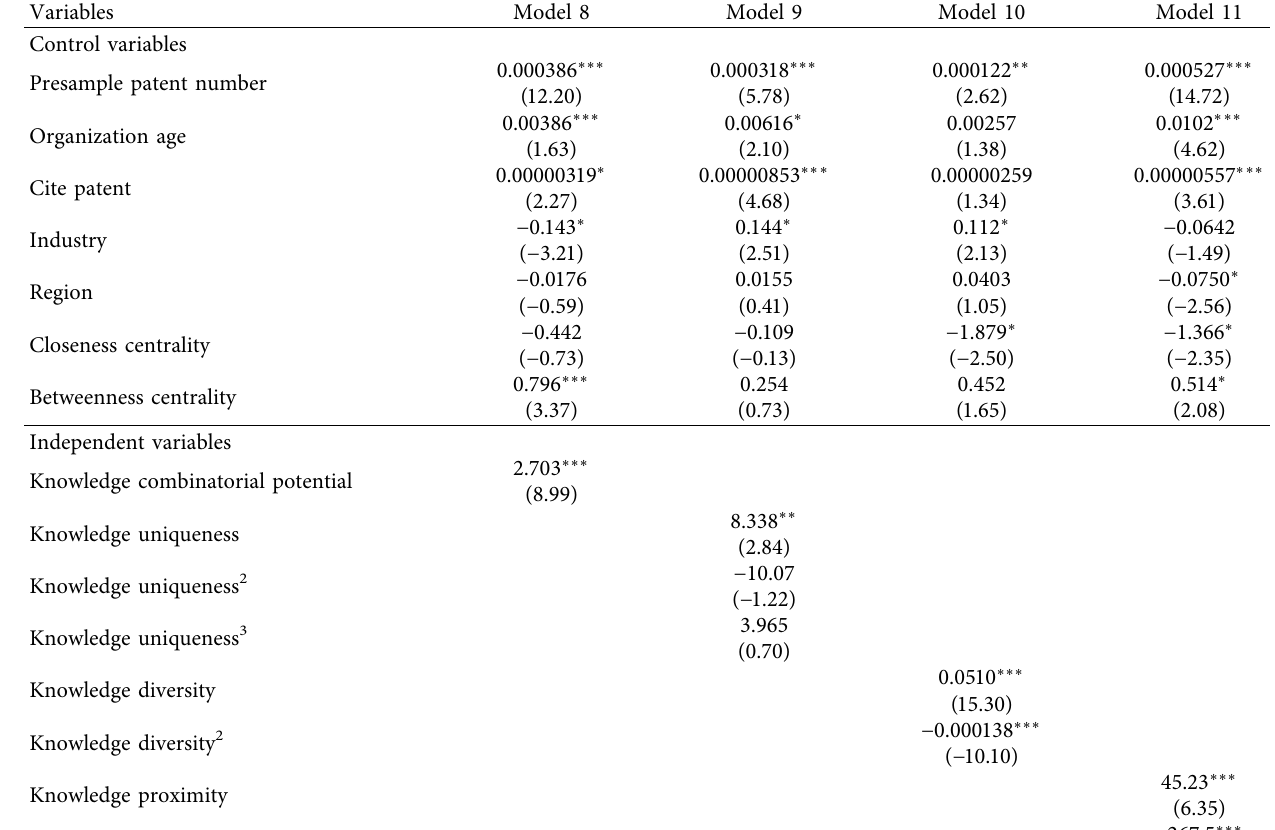
Table 3: Negative binomial analysis of the interaction effect between knowledge attributes and degree